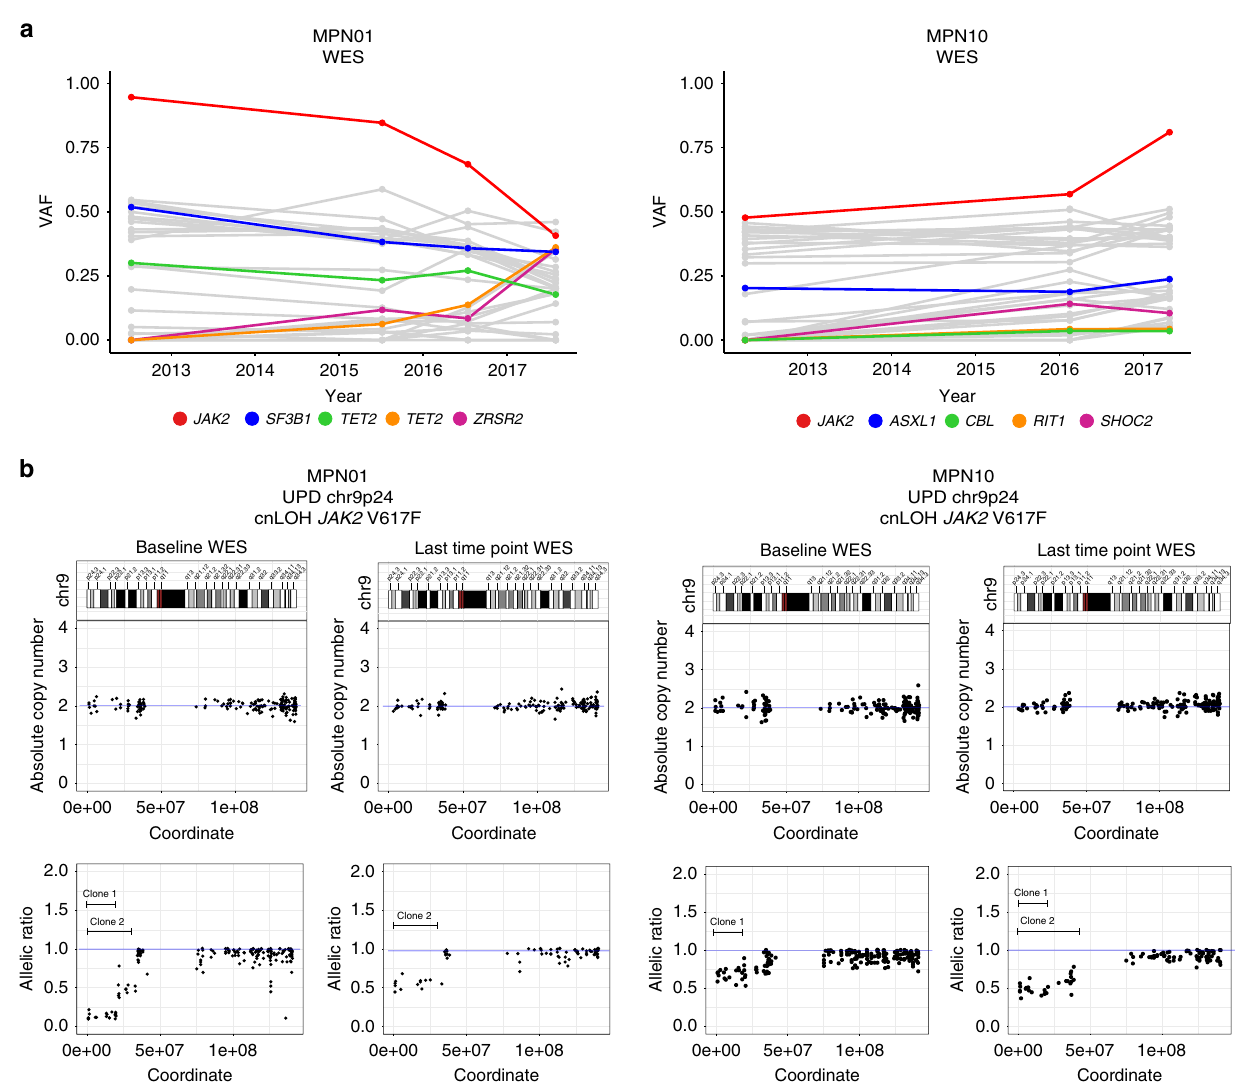
Fig. 2 Multiple CN-LOH affecting the JAK2 V617 locus. a Tracking variant allele frequency by serial WES in two patients with JAK2 CN-LOH. Each patient has multiple time points analyzed (MPN01: n = 4; MPN10: n = 3) with at least 5-years of follow-up. Known driver genes with mutation are shown as colored lines, with other genes shown as gray lines. b Depiction of evolution of multiple chromosome 9p acquired UPDs over time by analysis of baseline and last time point WES data. Chromosome 9 ideogram with bands (top), absolute copy number (middle) and allelic ratio (bottom) values ordered by genomic coordinates. Independent clones are indicated by butted lines. Source data are provided as a Source Data fi